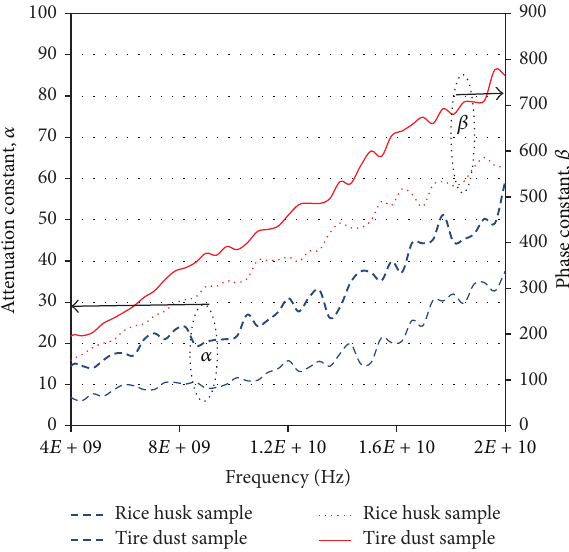
Figure 3: Frequency spectrum of the complex permittivity of the two samples fabricated using rice husks and tire dust. Figure 4: Frequency spectrum of the propagation constants of the two samples, that is,ricehusksandtiredustbased ontheir measured dielectric